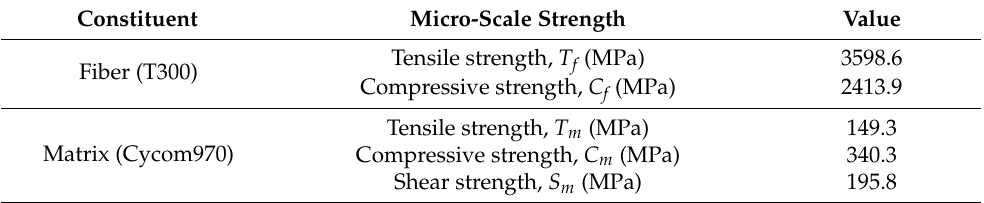
Figure 7. Procedures in determining the micro-scale strengths with macro-scale strengths of unidirectional laminates: ( a ) procedure in determining T f ; ( b ) procedure in determining C f ; ( c ) procedure in determining S m ; ( d ) procedure in determining T m and C m . Table 4. Micro-scale strengths of the constituents for T300/Cycom970 unidirectional